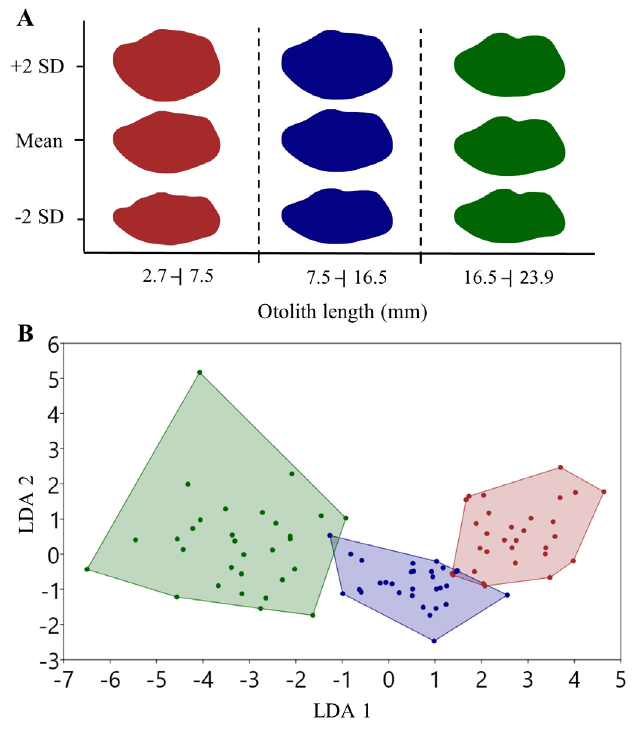
FIGURE 6 | Shape of otoliths of Centropomus parallelus by morphotypes. A. Otolith mean outline and standard deviation (SD). B . Linear discriminant (LD) analysis of harmonics of elliptic Fourier descriptors of otoliths. red = Morphotype 1; blue = Morphotype 2; green = Morphotype